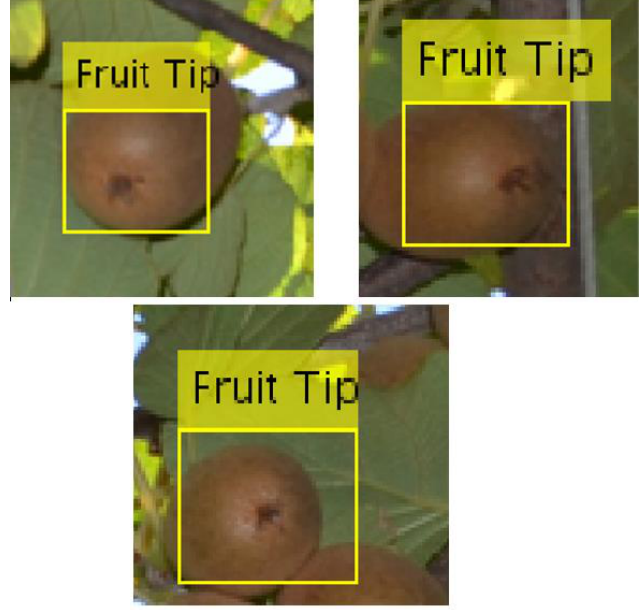
Figure 9. Examples of kiwifruit tip visibility.